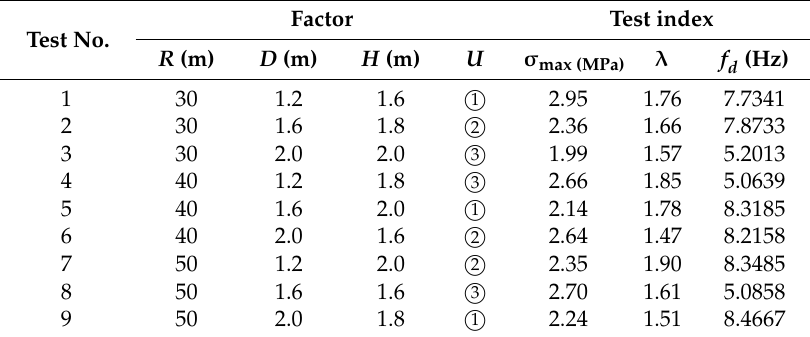
Table 7. L 9 ( 3 4 ) orthogonal array testing for three indices.